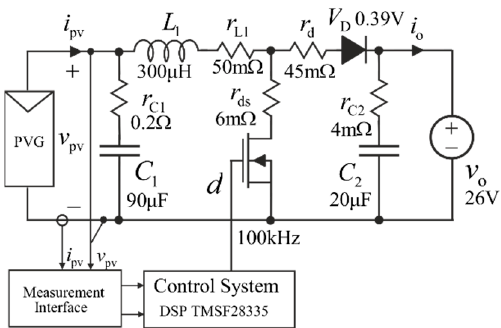
Figure 4. Boost-power-stage converter with the definition of its components, control system, and input/output terminal sources.